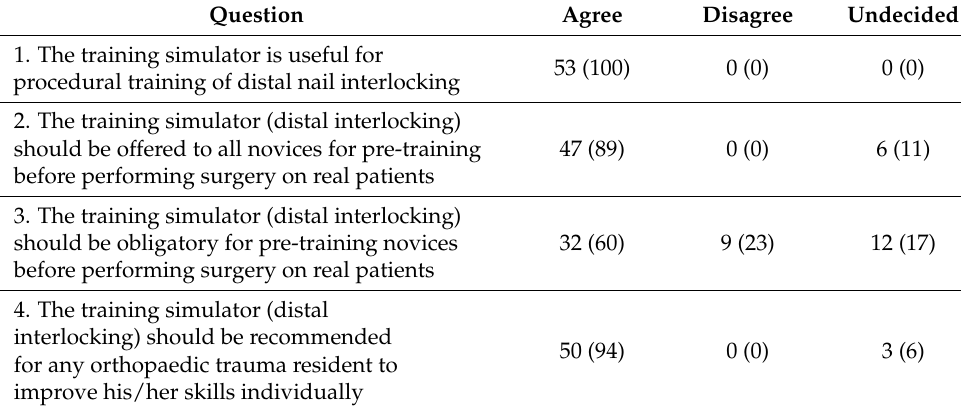
Table 1. Face validity: agree/disagree/undecided statements regarding the training simulator. Values are presented in n